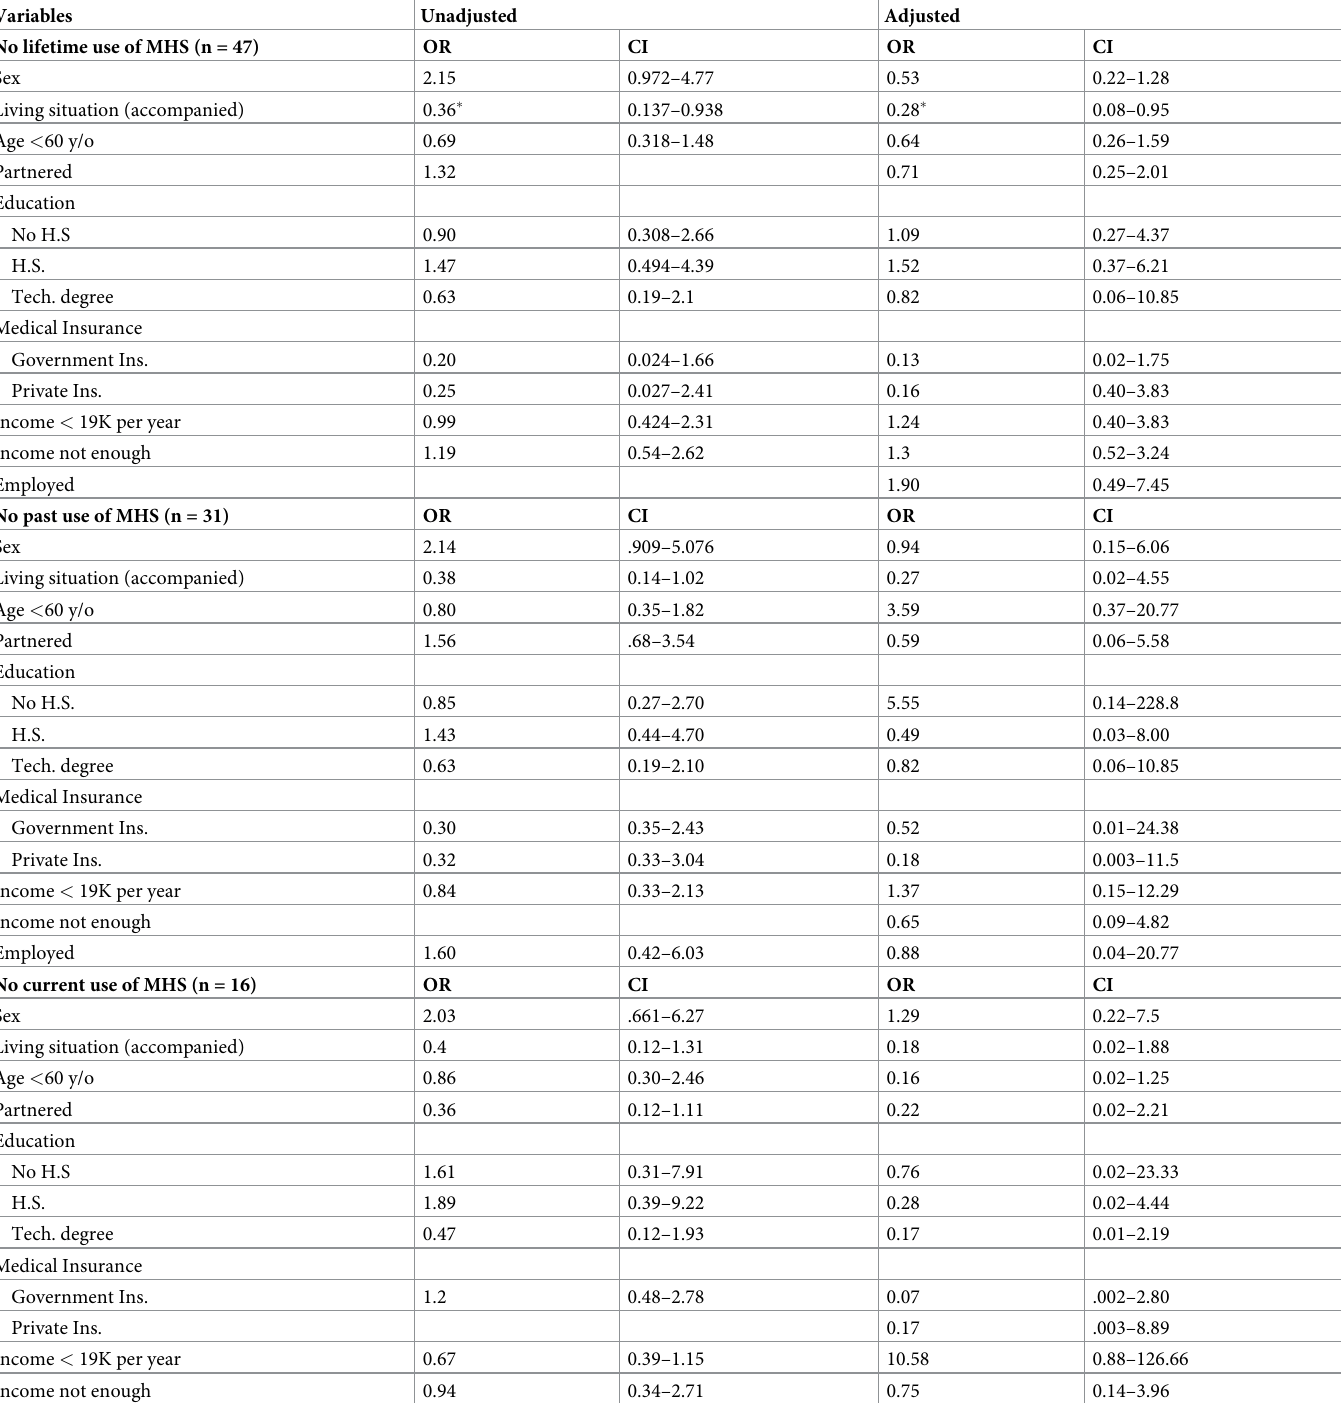
Table 4. Unadjusted and adjusted logistic regression models predicting likelihood of using mental health